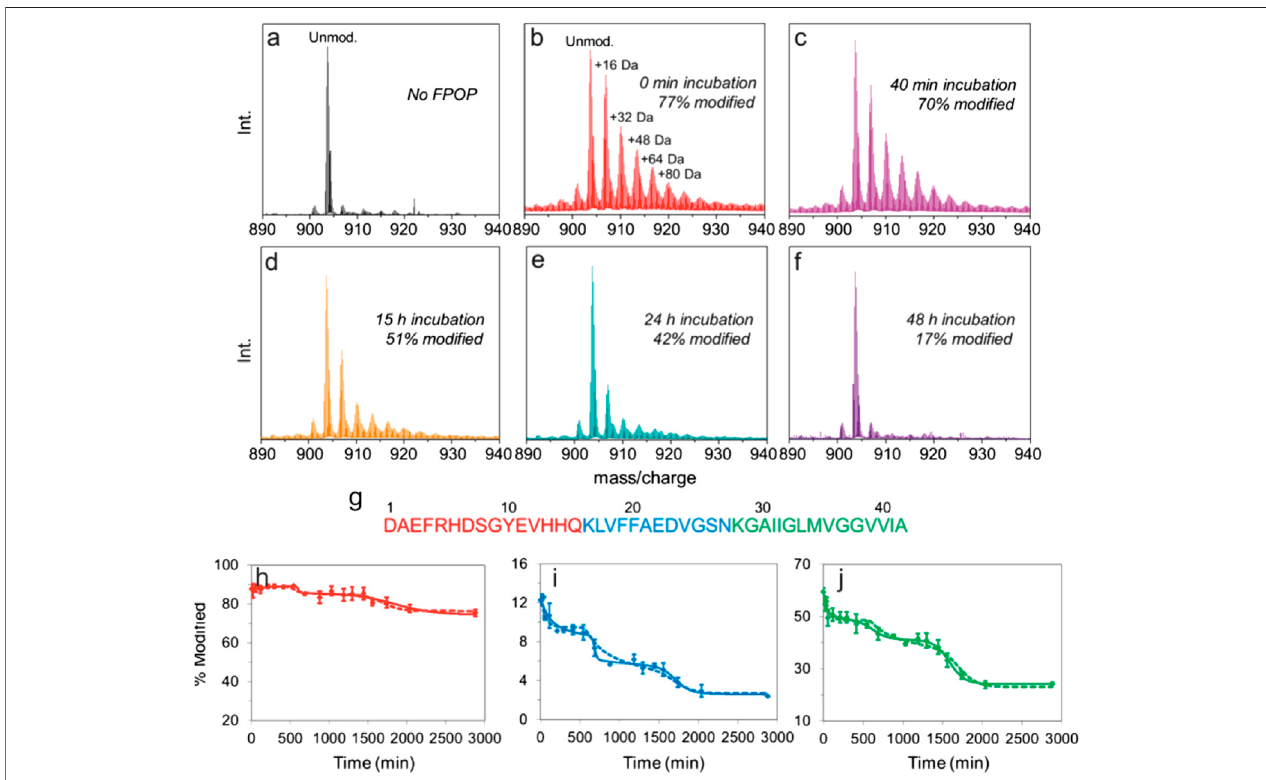
FIGURE6| FPOPanalysistoprobeamyloid- β (1 – 42)amyloidassembly. (A – F) Intactmassspectraofamyloid- β (1 – 42)(5+chargestate) (A) notsubjectedtoFPOP and after FPOP labeling at (B) 0 min, (C) 40 min, (D) 15 h, (E) 24 h, and (F) 48 h aggregation timepoints. (G) Sequence of amyloid- β (1 – 42) colored according to the three peptides produced after Lys-N digestion. (H – J) Extent of modi fi cation of the three Lys-N peptides of amyloid- β (1 – 42) as a function of aggregation time for the (H) N-terminalpeptides, (I) centralpeptide,and (J) C-terminalpeptide.Thesolidanddashedlinesaresimulateddataderivedusingasimplekineticmodelasoutlinedin (Li et al., 2016). Figure adapted with permission from (Li et al., 2016). Copyright: 2016 American Chemical Society.